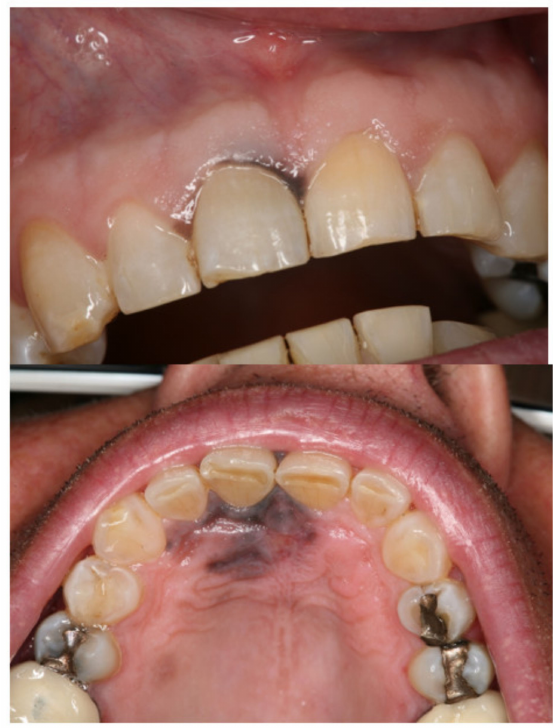
Figure 1. Clinical findings at first visit: on the labial marginal gingiva of tooth 11 and in the area of the anterior hard palate, an indistinctly delimited blackish oral mucosal change is evident, which is clinically highly suspect of an oral mucosal melanoma.